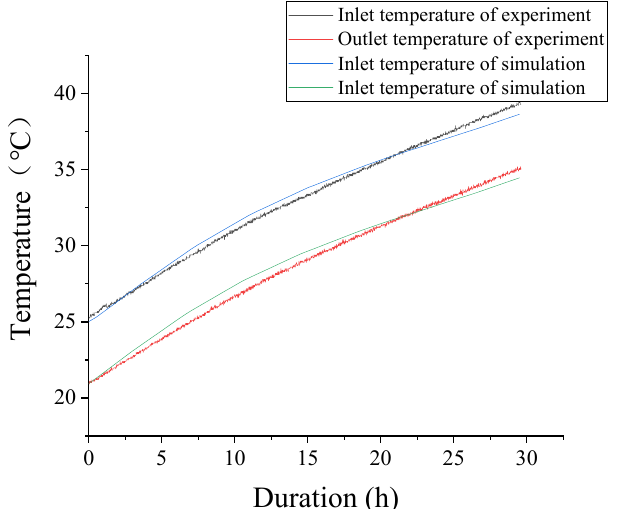
Figure 5. Comparison of the experimental and simulated values of temperature during phase